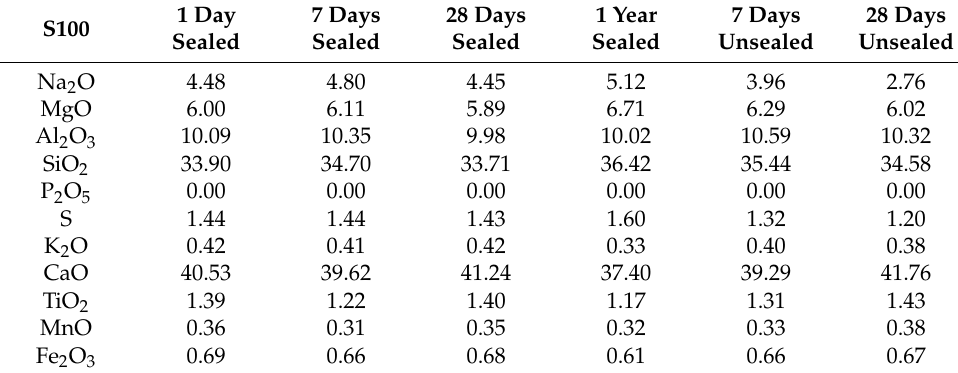
Table 8. Bulk chemistry obtained with XRF for the paste S100.